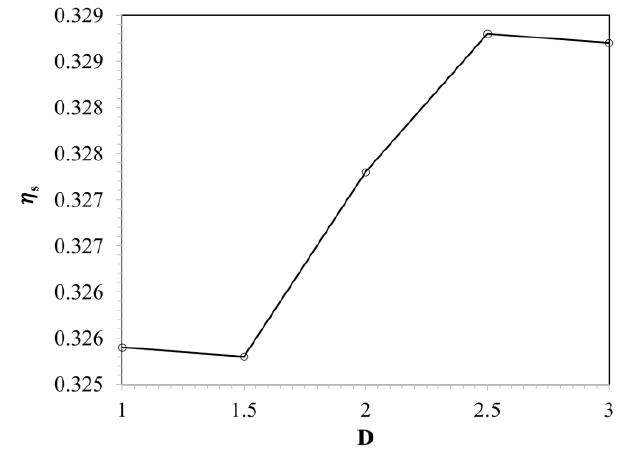
Figure 11. 𝜂 𝑠 with expansion in front of the inlet hole. Figure 11. η s with expansion in front of the inlet